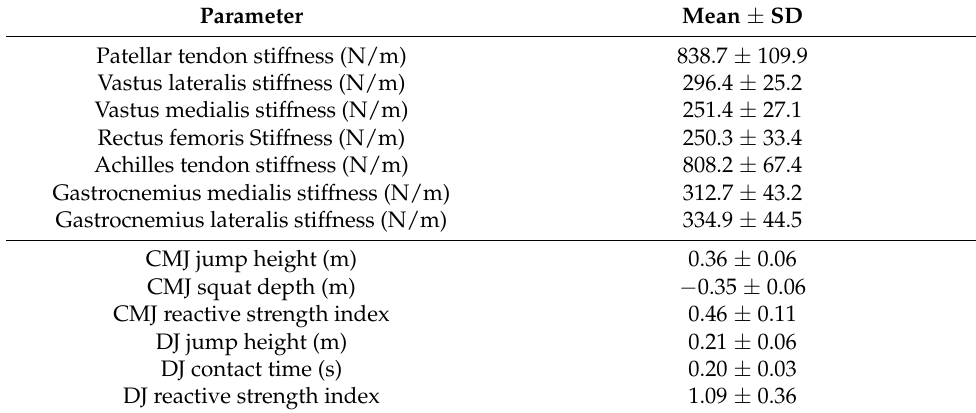
Table 1. Mean and standard deviation (SD) of the assessed